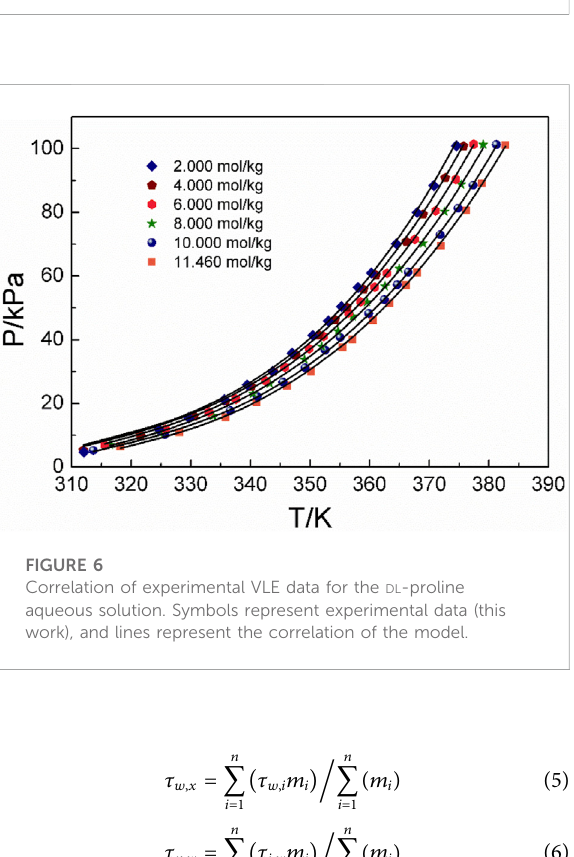
FIGURE 4 Correlation of experimental VLE data for the L -glutamic acid aqueous solution. Symbols represent experimental data (this work), and lines represent the correlation of the model.